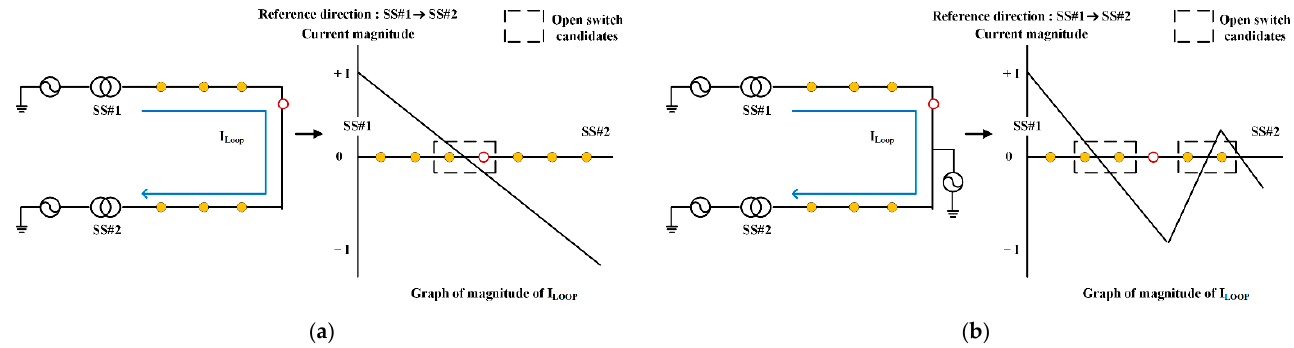
Figure 6. Current patterns in the loop with DG integration: ( a ) loop with loads only; ( b ) loop with DG.